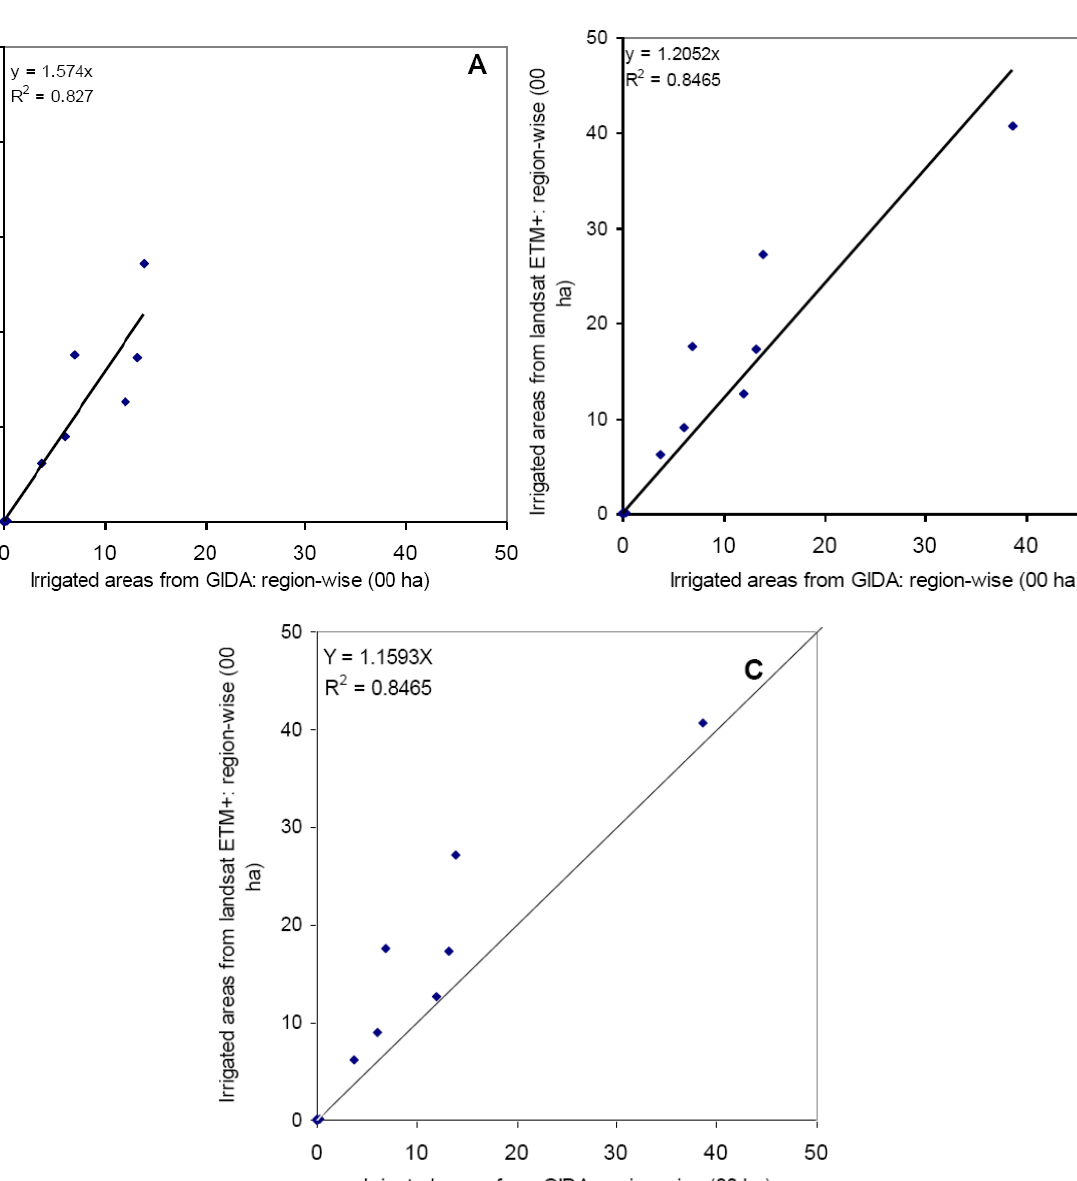
Figure 5. Comparison of remote sensing derived irrigated areas of Ghana with national statistics: (A) plot without 1 outlier point, (B) plot with outlier point, (C) visual aid to compare the distribution of points against a perfect 1:1